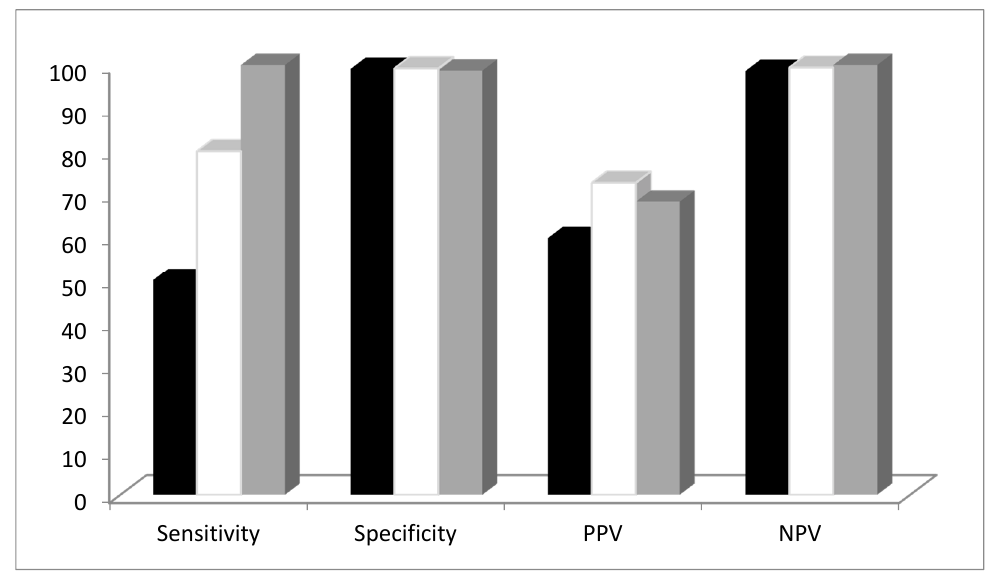
Figure 1. Diagnostic performance of SARS-CoV-2 IgG serology (index test) in comparison with RT-PCR (reference standard) considering a time interval of at least 14 days and 20 days between swabs and serology. PPV = positive predictive values, NVP = negative predictive value. Irrespective of the time interval between serology and positivity to RT-PCR. 14 days after positivity to RT-PCR. 20 days after positivity to RT-PCR.